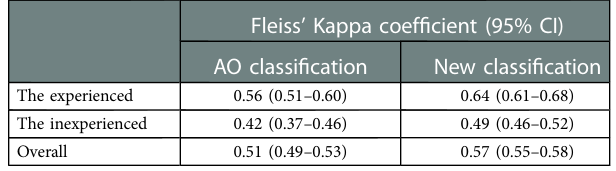
TABLE 3 Inter-observer reliability.